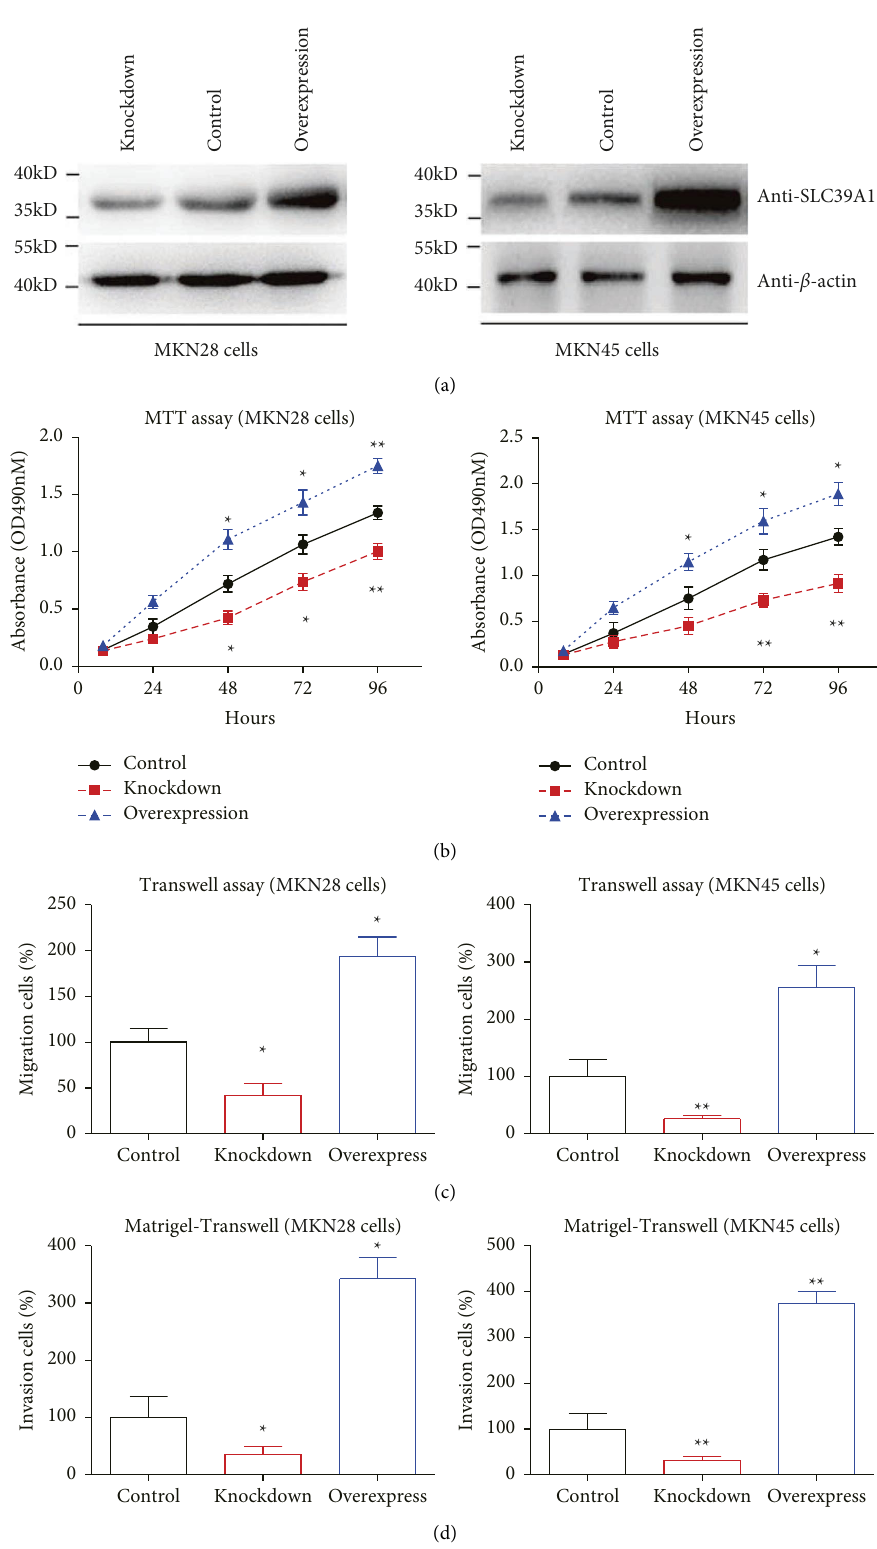
Figure 3: SLC39A1 showed oncogenic efects in gastric adenocarcinoma cells. (a) Transfection efciencies of SLC39A1 overexpression, SLC39A1-knockdown, and pLKO.1 vector control cells were tested via Western blotting in MKN28 and MKN45 cells, respectively. (b) MTT experiments were conducted to test the efects of silencing or overexpressing on gastric adenocarcinoma cell proliferation. (c) Migration capacities of gastric adenocarcinoma cell lines were tested by Transwell assays. (d) Invasion capacities of gastric adenocarcinoma cell lines were evaluated by Matrigel-Transwell assays. Data was presented as Mean ± SD from three independent repeats. ∗ indicates P < 0 . 05 by Student’s t -test compared with vector control